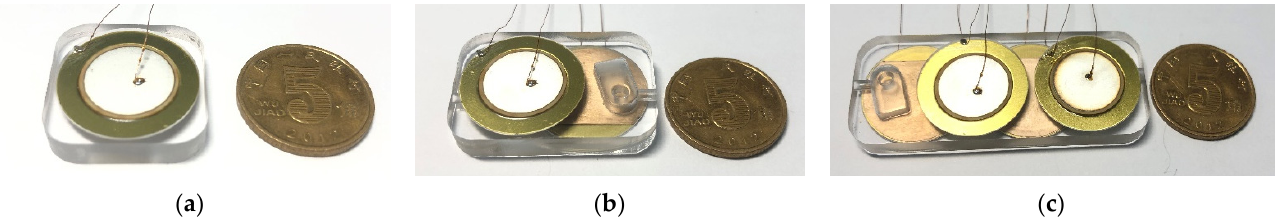
Figure 4. Photos of the piezoelectric micropump prototype. ( a ) Single-chamber. ( b ) Double-chamber. ( c ) Four-chamber.